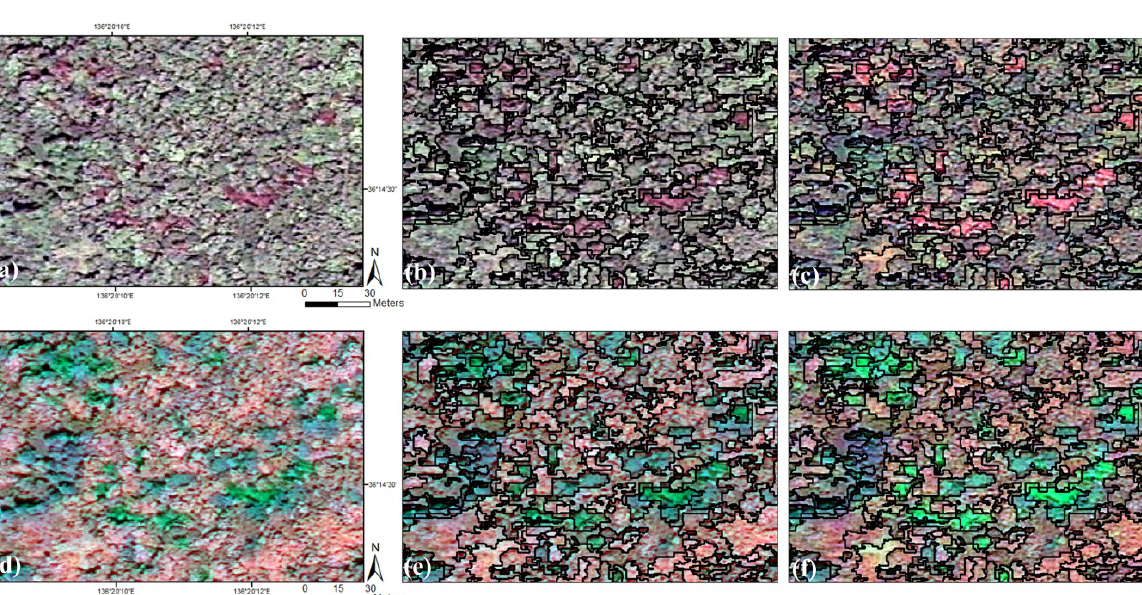
Figure 3. True color IHS pansharpened image of: ( a ) a subset of the forested study area, ( b ) the most spatially-accurate segmentation of the IHS image, and (c) image segments from (b) overlaid on the SFIM pansharpened image to extract more accurate mean spectral values for the segments. Brown areas in the images show trees severely damaged or killed by Raffaelea quercivora. False color imagery (NIR, R, G) used in place of the true color imagery in ( d – f ) for visualization purposes. White-colored areas show stressed, damaged, or dead trees, which are clearer in